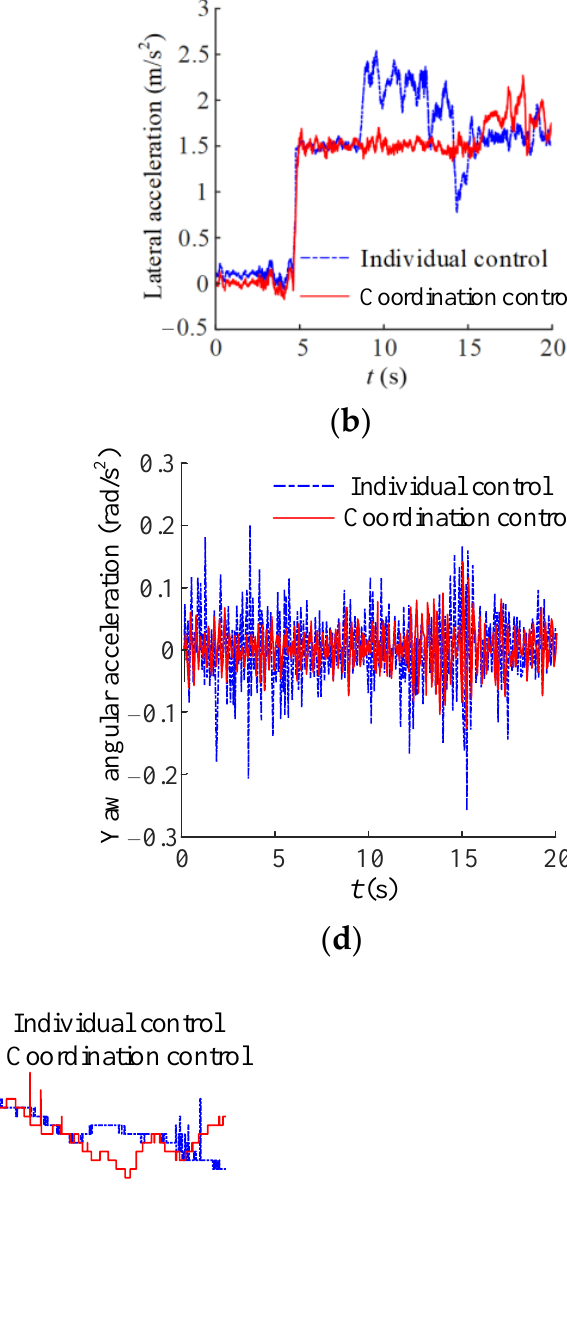
( b ) ( c ) Figure 9. Comparison diagram of RMS values at different speeds: ( a ) body roll angle; ( b ) roll angle acceleration; ( c ) yaw angular acceleration. It is evident therein that when the RMS value of vehicle speed reaches the abovemen-